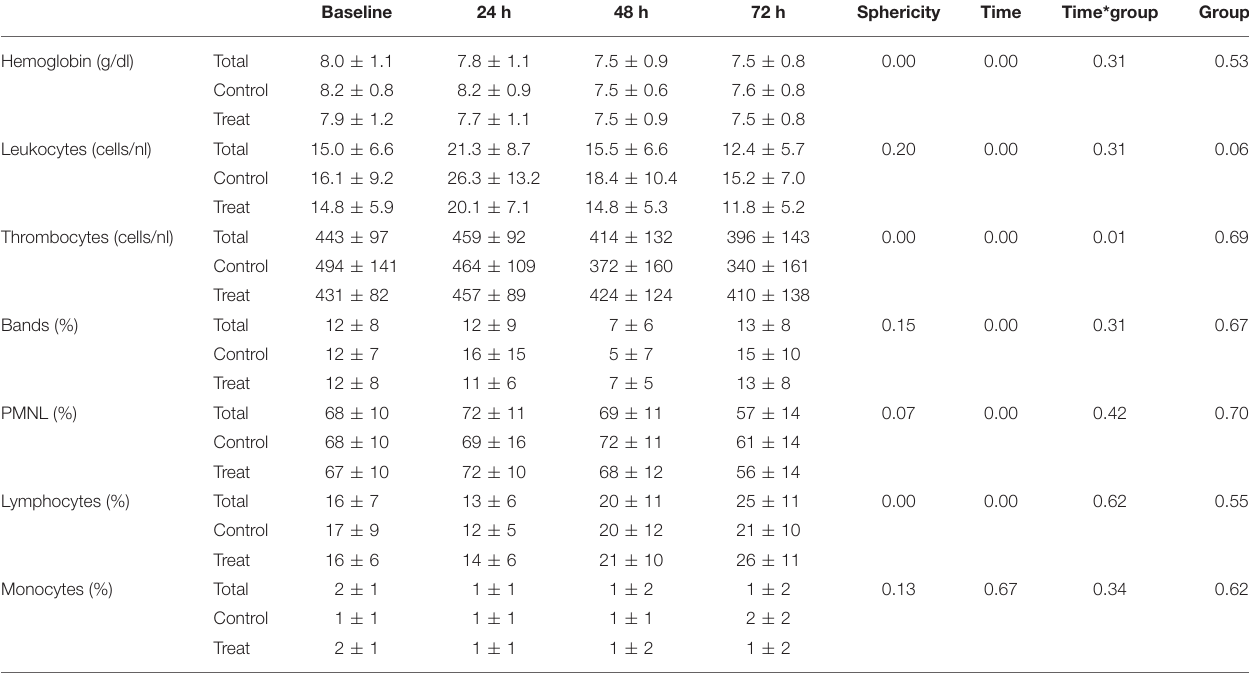
TABLE 3 | Blood cell differentials. Baseline Sphericity Group Hemoglobin